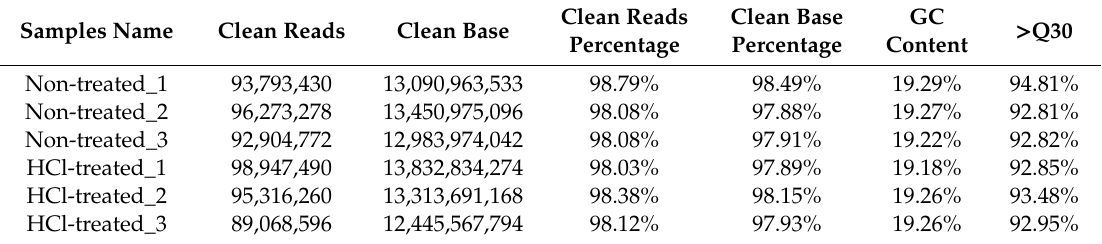
Table 2. Summary ofWGBSdataof diapause-destined eggs (Non-treated) and diapause-terminated eggs